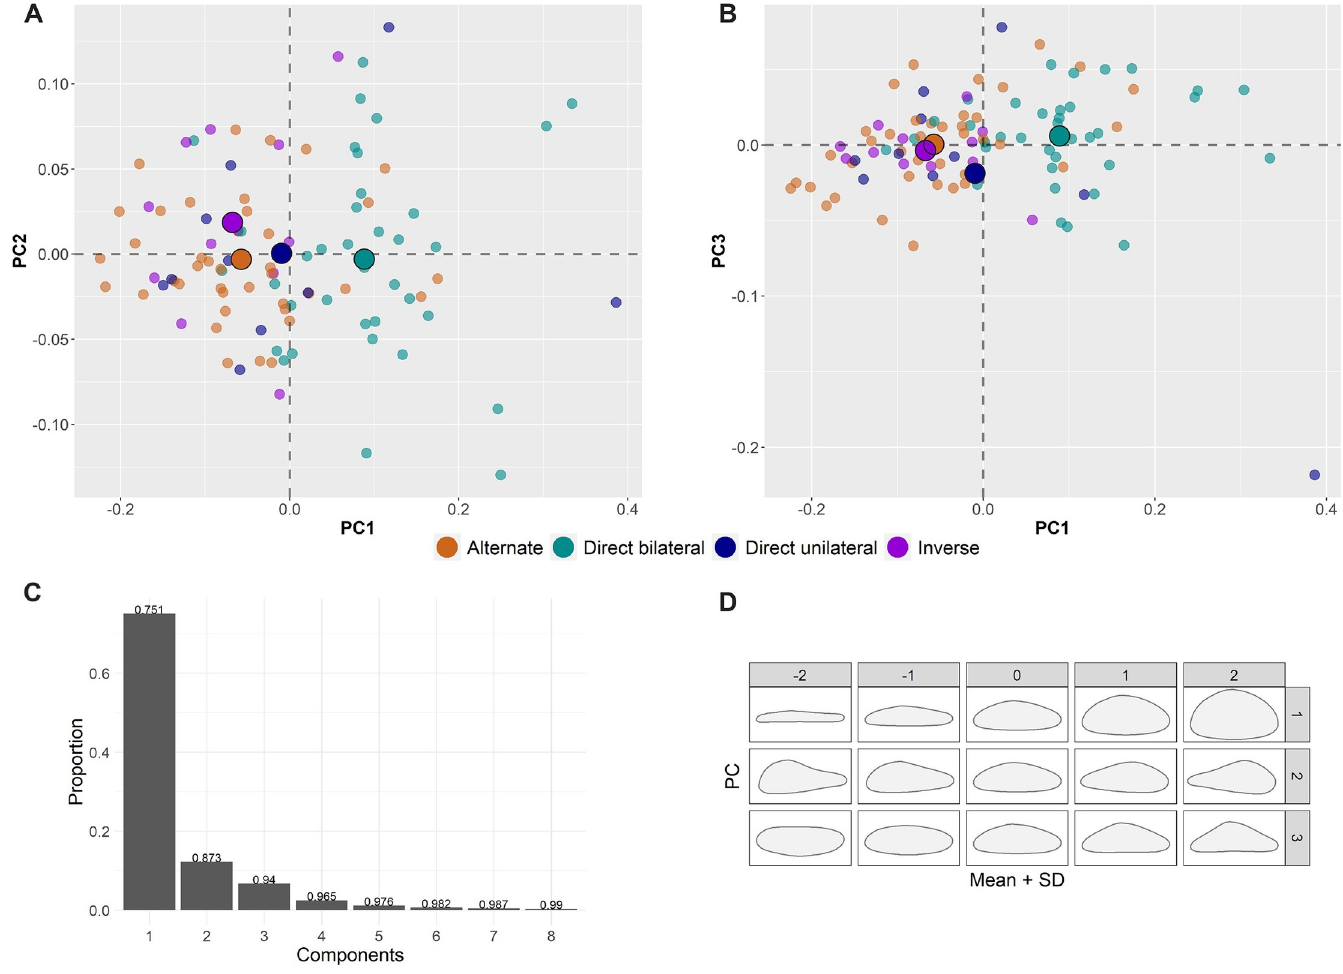
Fig 9. 2D shape analysis of the upper cross-section. A and B are the bivariate plots of the first three principal components (PC1 versus PC2 and PC1 versus PC3) colored according to retouch position and with the mean of each group identified with bigger dots (see legend for colors). C displays the proportion of variance explained by the first eight principal components. D presents the shape variation of the first three principal components. SD stands for standard deviation.